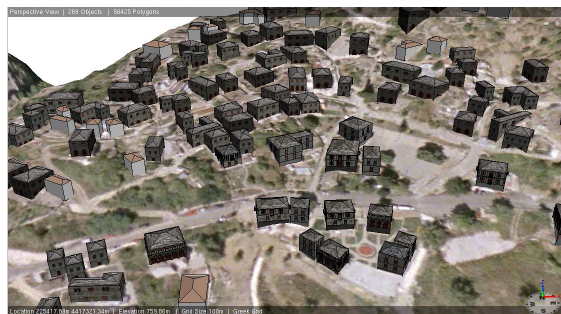
Figure 12. 3D model of the case study area, CityEngine Interface